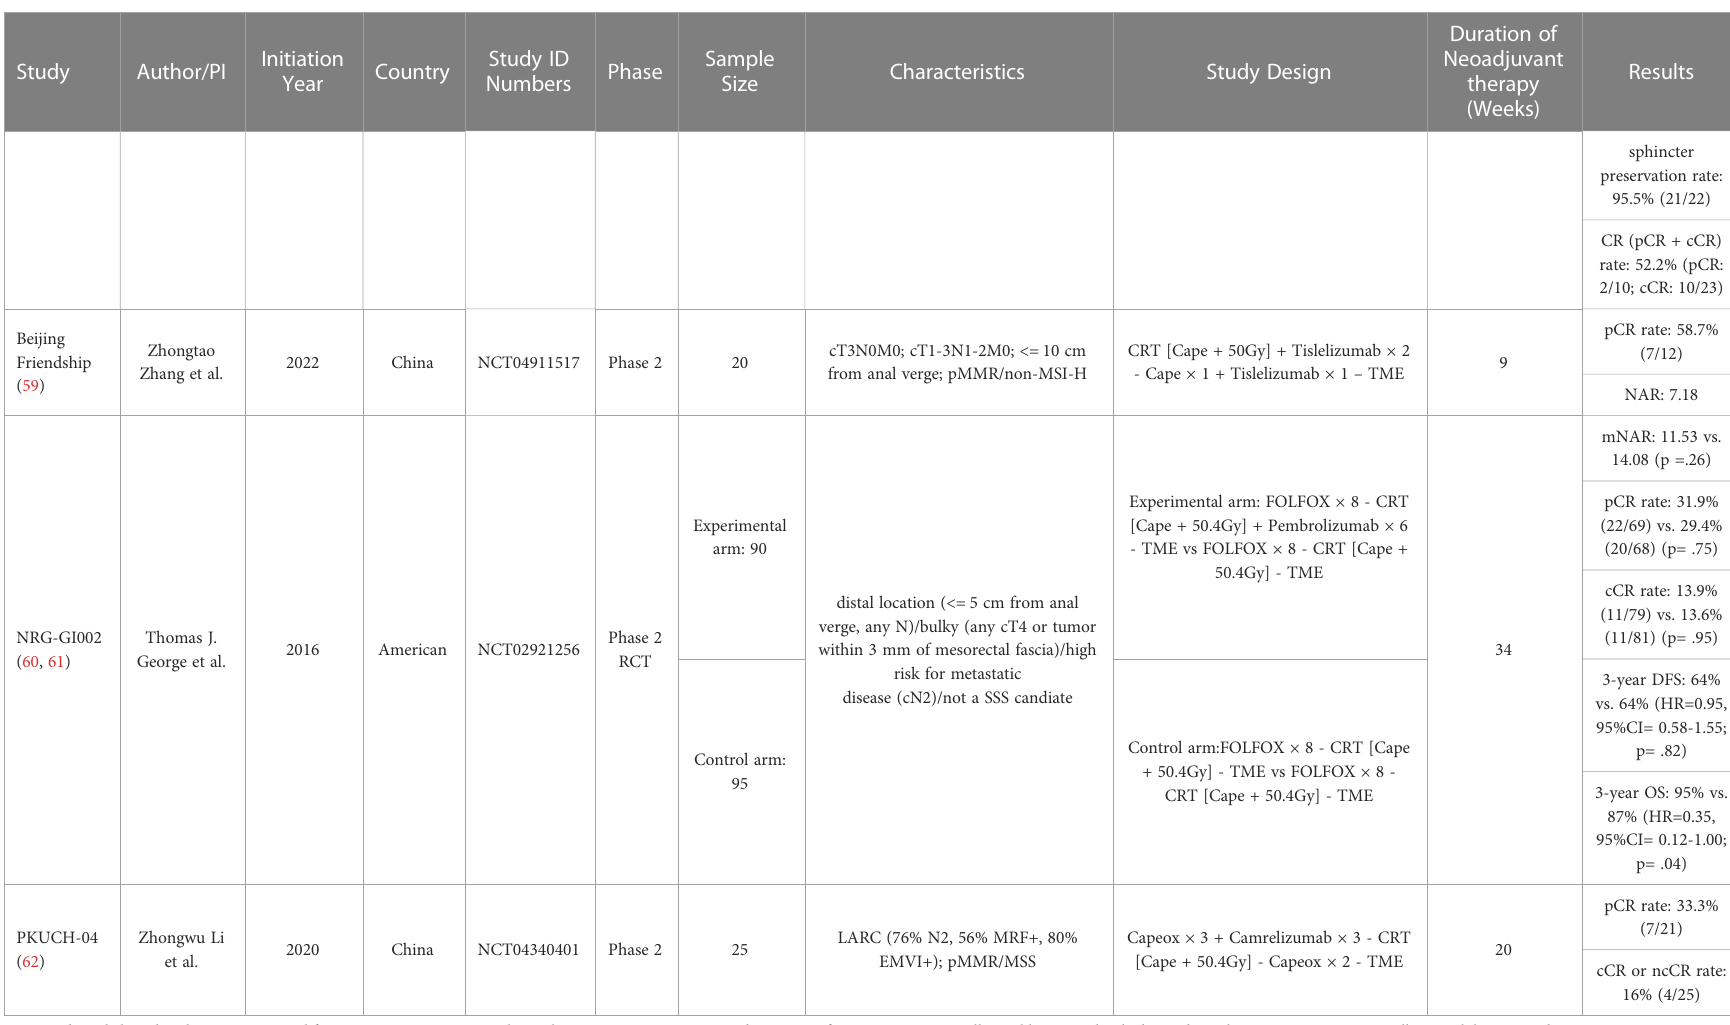
Experimental arm: FOLFOX × 8 - CRT [Cape + 50.4Gy] + Pembrolizumab × 6